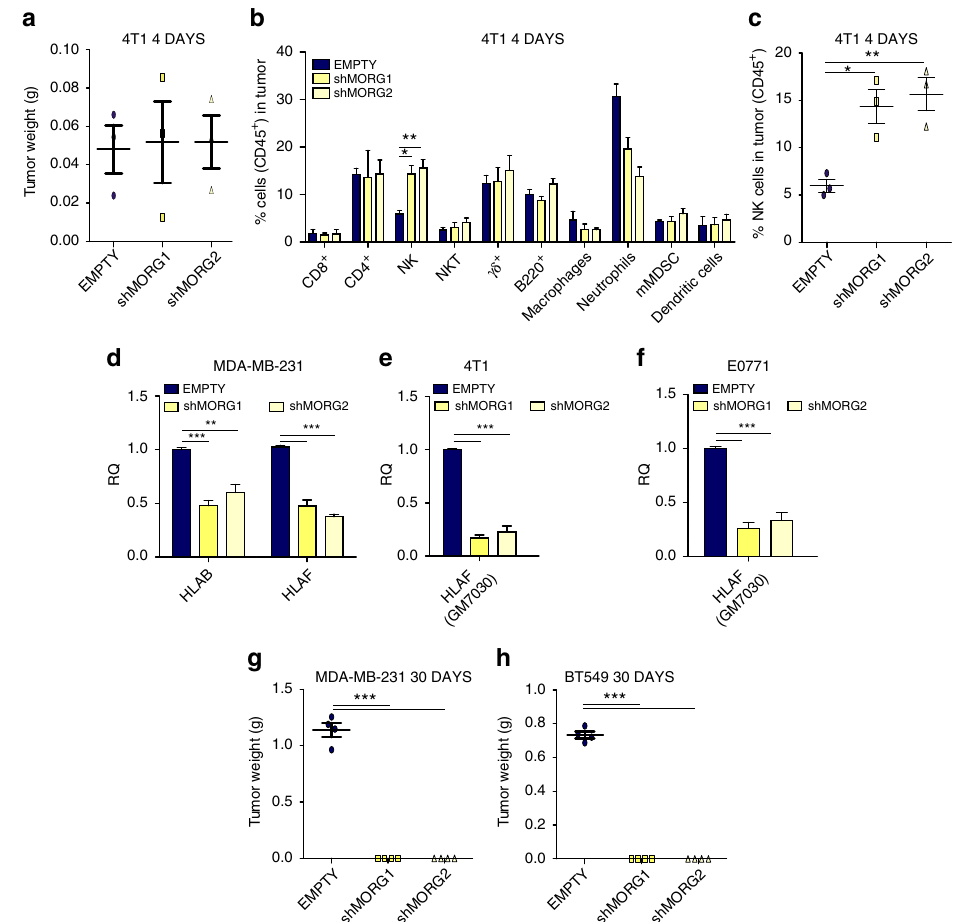
Fig. 7 High Morgana levels in cancer cells induce NK cells recruitment at early phases of primary tumor formation. a , b Tumor weight a and percentage of immune cells (gated on CD45 + cells) b 4 days after subcutaneous injection of 4T1 cells EMPTY or shMORG1 and shMORG2 ( n = 3 BALB/c mice per group). c Percentage of natural killer (NK) cells detected in the primary tumor of each mouse 4 days after injection of 4T1. d Gene expression analysis by Real-time PCR of HLA-F and HLA-B in MDA-MB-231. e , f Gene expression analysis by Real-time PCR of GM7030 gene (mouse ortholog of HLA-F) in 4T1 e and E0771 f EMPTY or shMORG1 and shMORG2. g Graph showing the tumor weight 30 days after injection of MDA-MB-231 EMPTY or shMORG1 and shMORG2 ( n = 4 nude mice per group). h Tumor weight 30 days after subcutaneous injection of EMPTY or shMORG1 and shMORG2 BT549 cells ( n = 4 nude mice per group). Bars in graphs represent standard errors (* p < 0.05; ** p < 0.01; *** p <